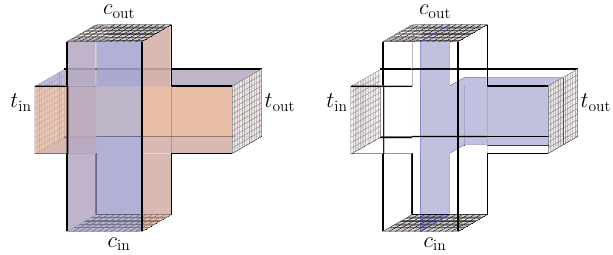
FIG. 7. Left: a CX (controlled- NOT ) gate with control qubit c and target qubit t has two ports that are treated as inputs ( c in and t in ) and two ports that are treated as outputs ( c out and t out ). The control qubit c is presented as progressing from bottom to top, whereas the target qubit is presented as progressing from left to right. Right: the support of one instance of the logical correlator membrane is presented. In this case, the support of the membrane at the ports fully determines which stabilizer it represents at